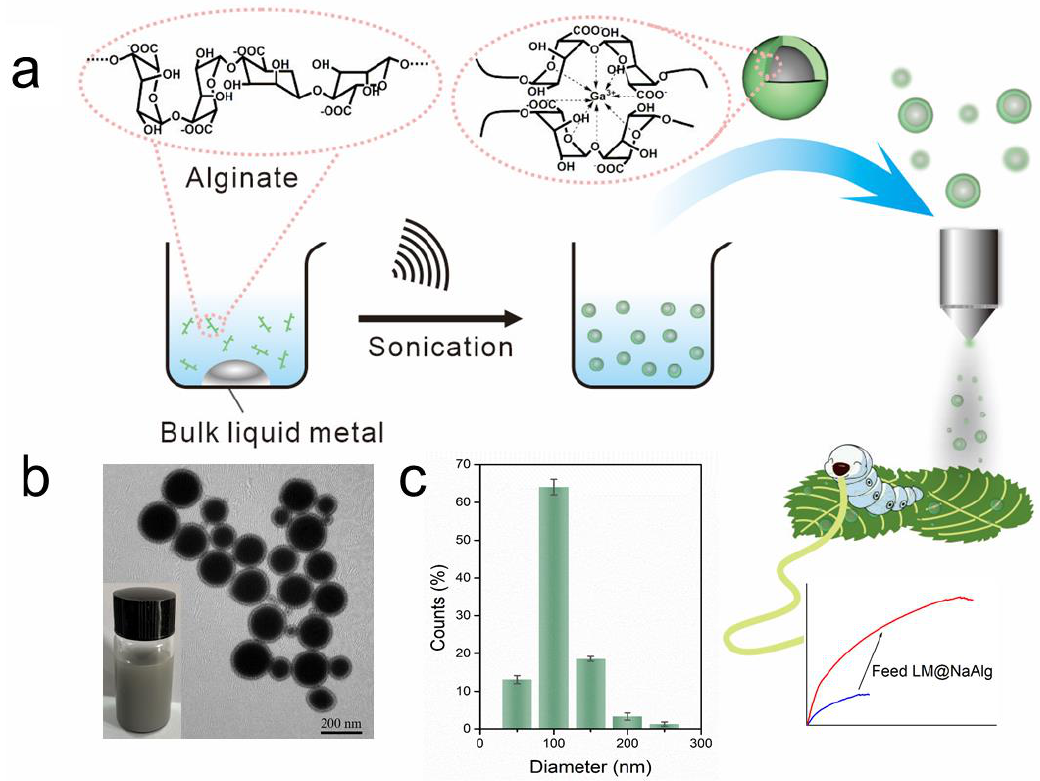
Figure 1. Preparation of the LM@NaAlg nanodroplet modified silks. ( a ) Schematic illustration of the sonicating liquid metal in the alginate solution and the liquid metal nanodroplets shelled in alginate microgel; ( b ) TEM image of the LM@NaAlg nanodroplets; ( c ) diameter histogram of the LM@NaAlg nanodroplets, sonication time of 60 min, and alginate concentration of 0.6 wt%.